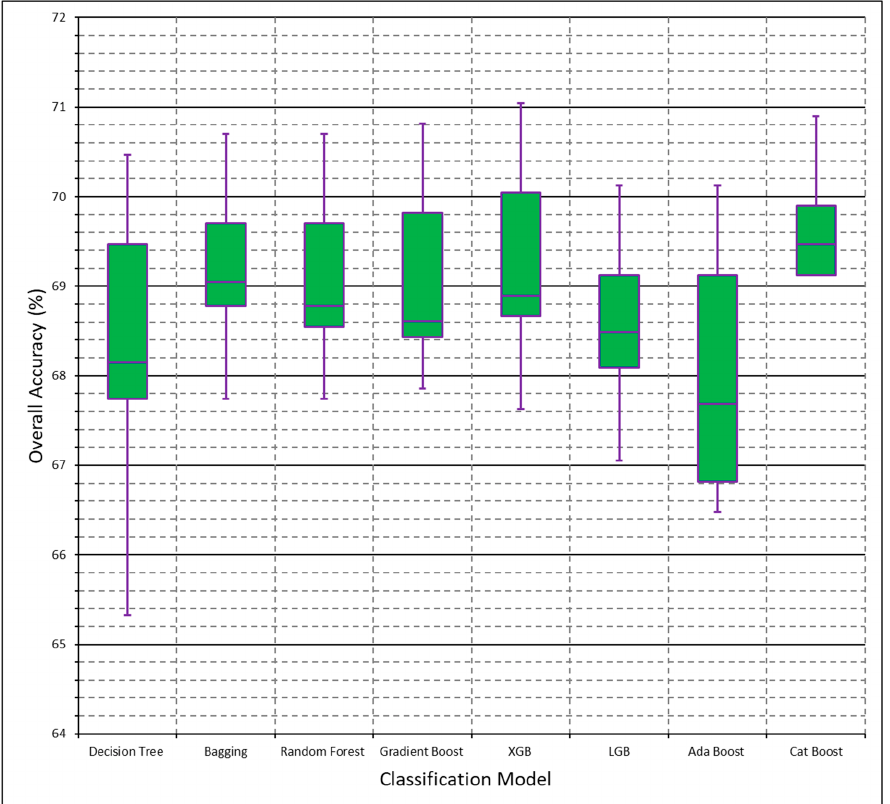
Table 6. Binary model performance metrics between each refinement step.